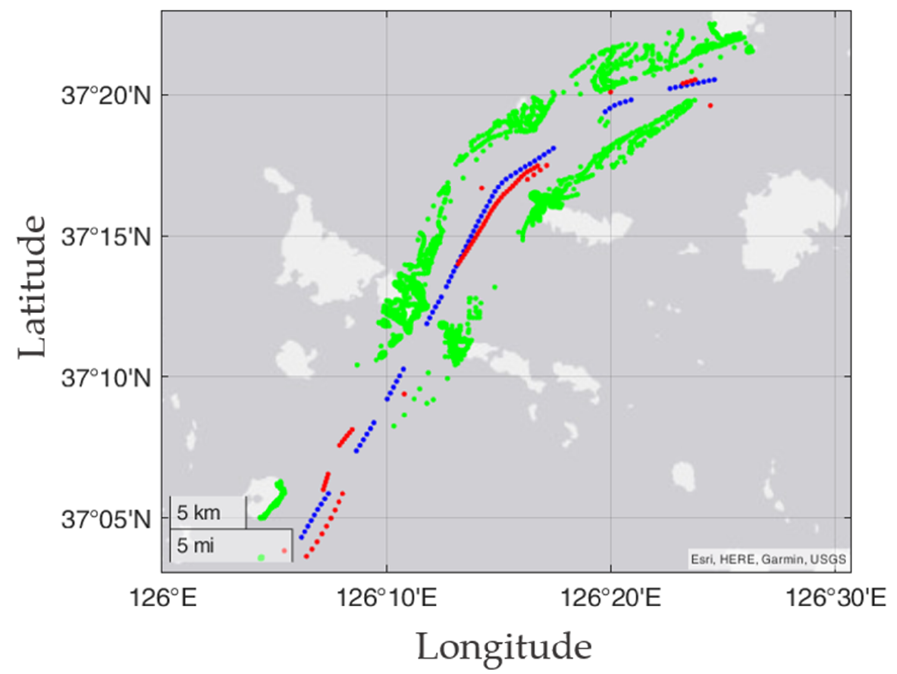
Figure 4. CRSs including traffic and geographic